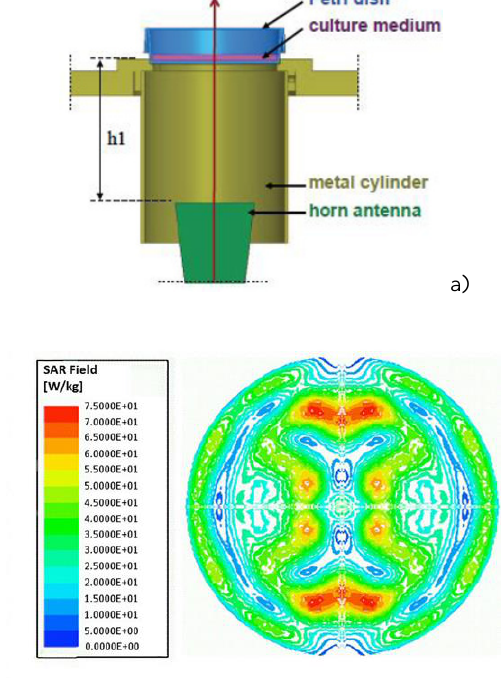
Fig. 3. (a) Detail of the setup showing the position of the petri dish; (b) SAR distribution on the cell layer at the bot- tom of the petri dish